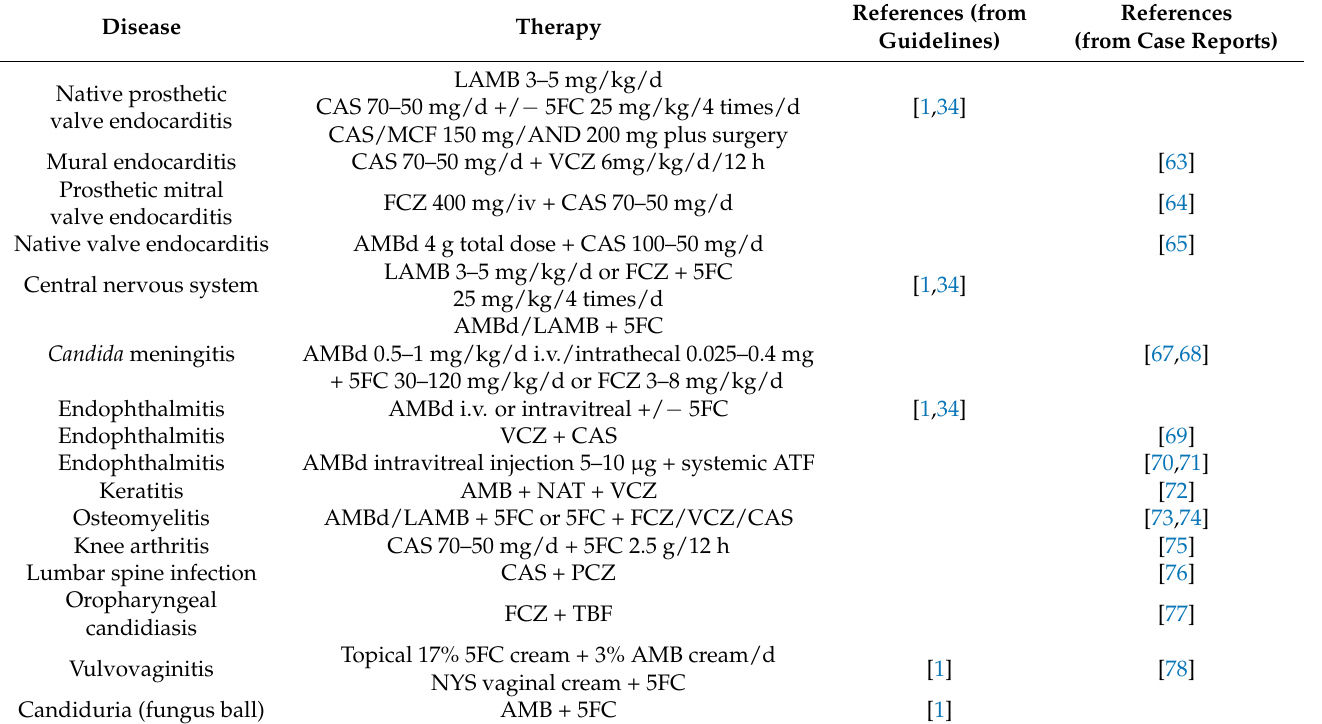
Table 1. Main antifungal combinations used for difficult to treat Candida infections.